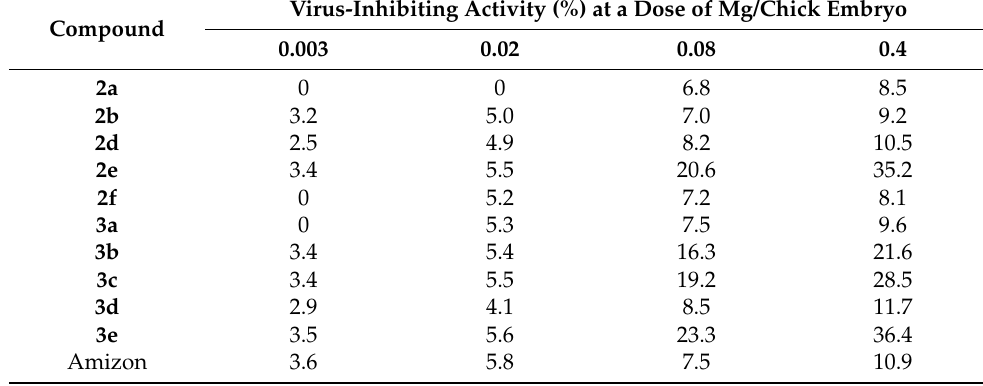
Table 3. Virus-inhibiting activity of the test compounds when exposed to the swine influenza A/swine/Iowa/30 (H1N1)